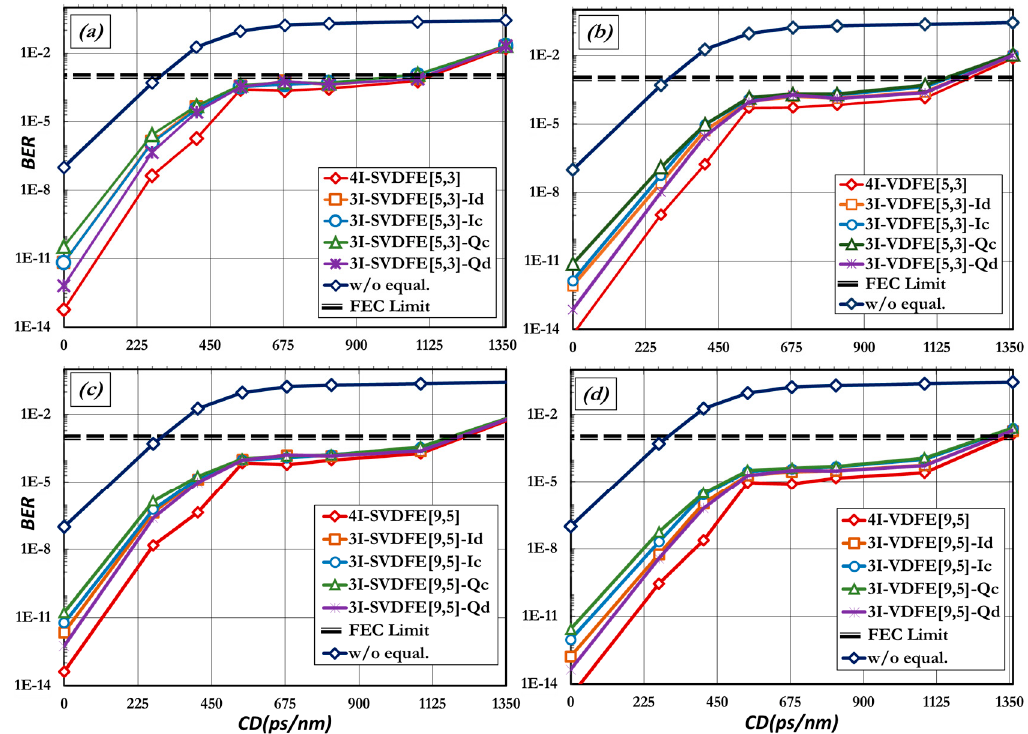
Figure 9. Estimated BER of optical links that utilize ( a ) SVDFE[5,3]; ( b ) VDFE[5,3]; ( c ) SVDFE[9,5]; and ( d ) VDFE[9,5] equalizers depending on the ignored input signal ( I c , I d , Q c , Q d ). 4 I and 3 I denote the number of inputs.